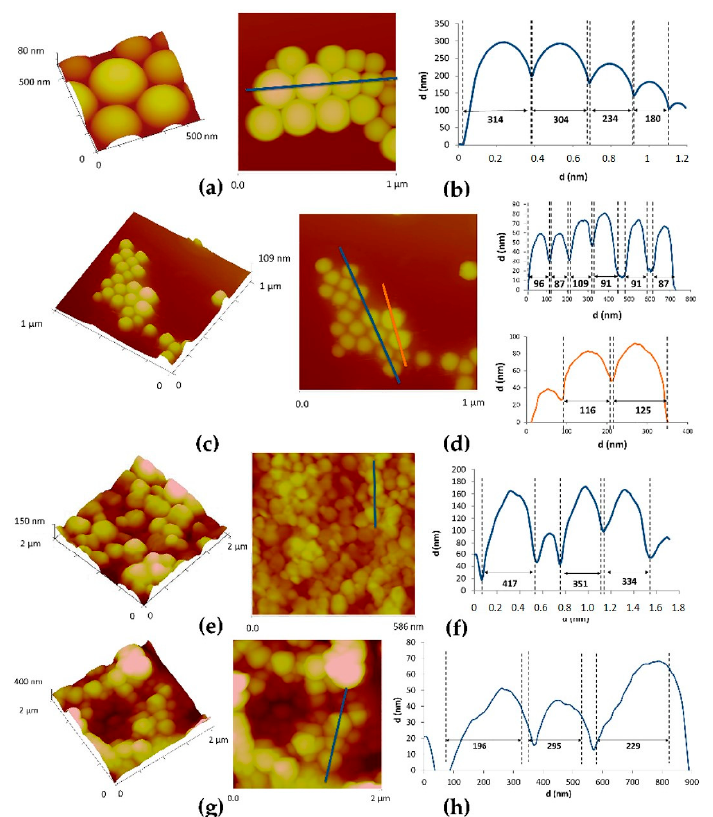
Figure 7. AFM topographic images of NPs under study. ( a , b ) Empty PLGA NPs, ( c , d ) Extract-loaded PLGA NPs, ( e , f ) Empty PCL NPs, ( g , h ) Extract-loaded PCL NPs. 3D images ( a , c , e , g ) and cross section analysis ( b , d , f , h ). Table 1. Inherent energy attributes of polymer-rutin complexes calculated using static-lattice atomistic simulations (SLAS) in vacuum.